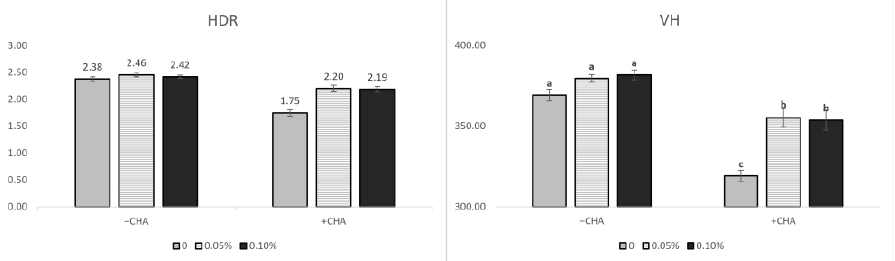
Figure 2. Effects of stimbiotic on the villus height (VH) and height-to-depth ratio (HDR) in the ileum of weaned piglets. Data are represented as the mean ± standard error. a,b,c Different superscript letters indicate significant differences between groups ( p < 0.05).